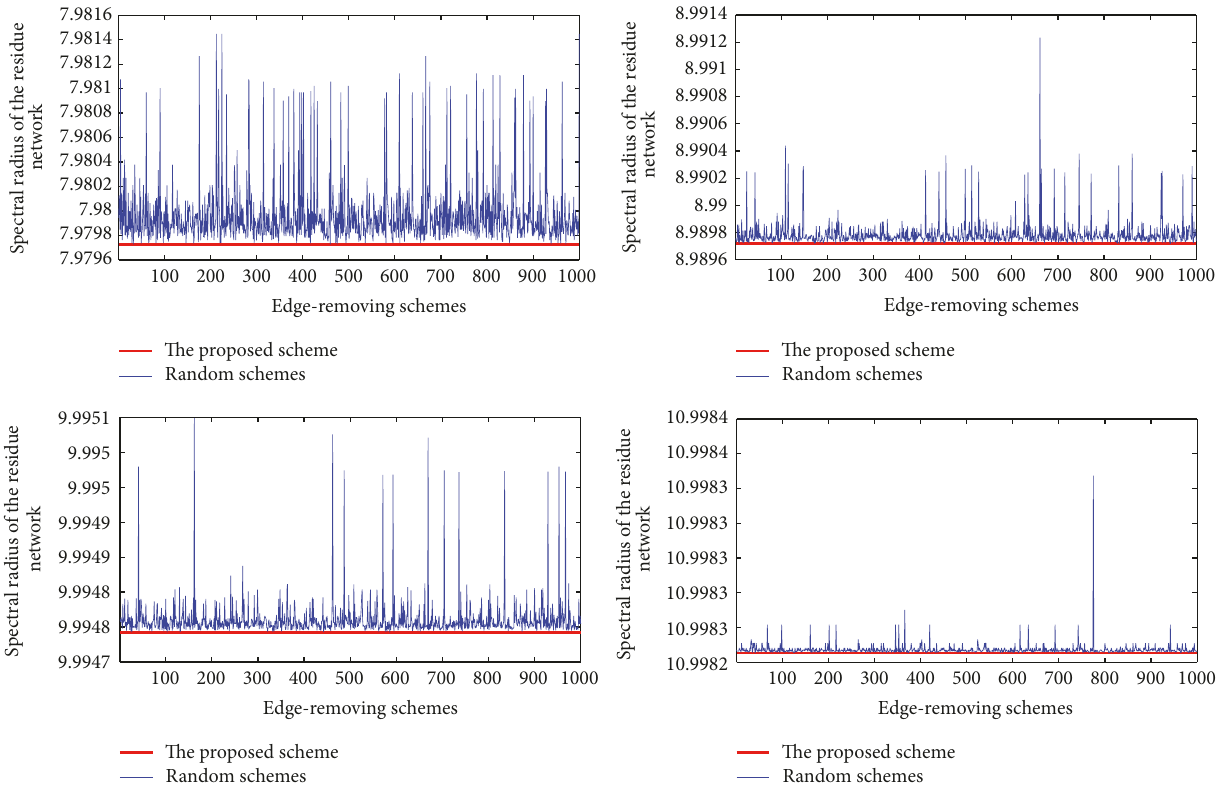
Figure 4: The proposed candidate (red) versus 10 3 random candidates